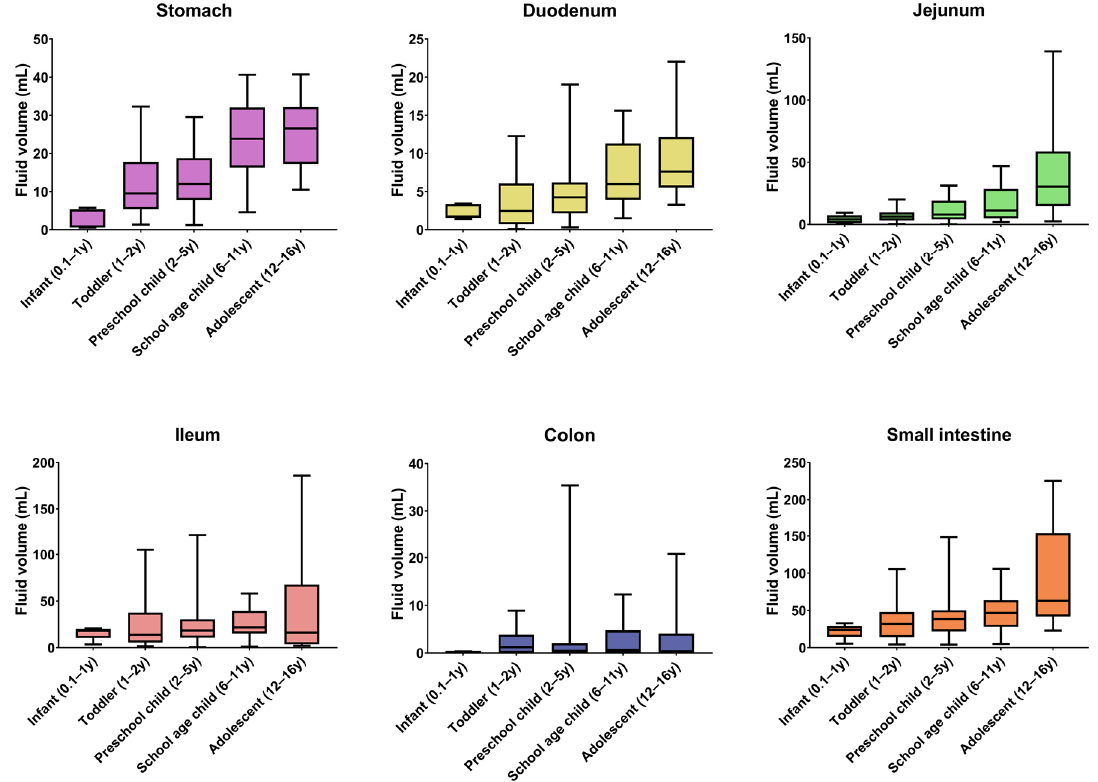
Figure 3. GI fluid volumes per segment and per pediatric subpopulation. Boxes indicate the 25th and 75th percentile and the median. Whiskers indicate the minimum and maximum. The number of children per subpopulation can be found in Table 2. (y = year)